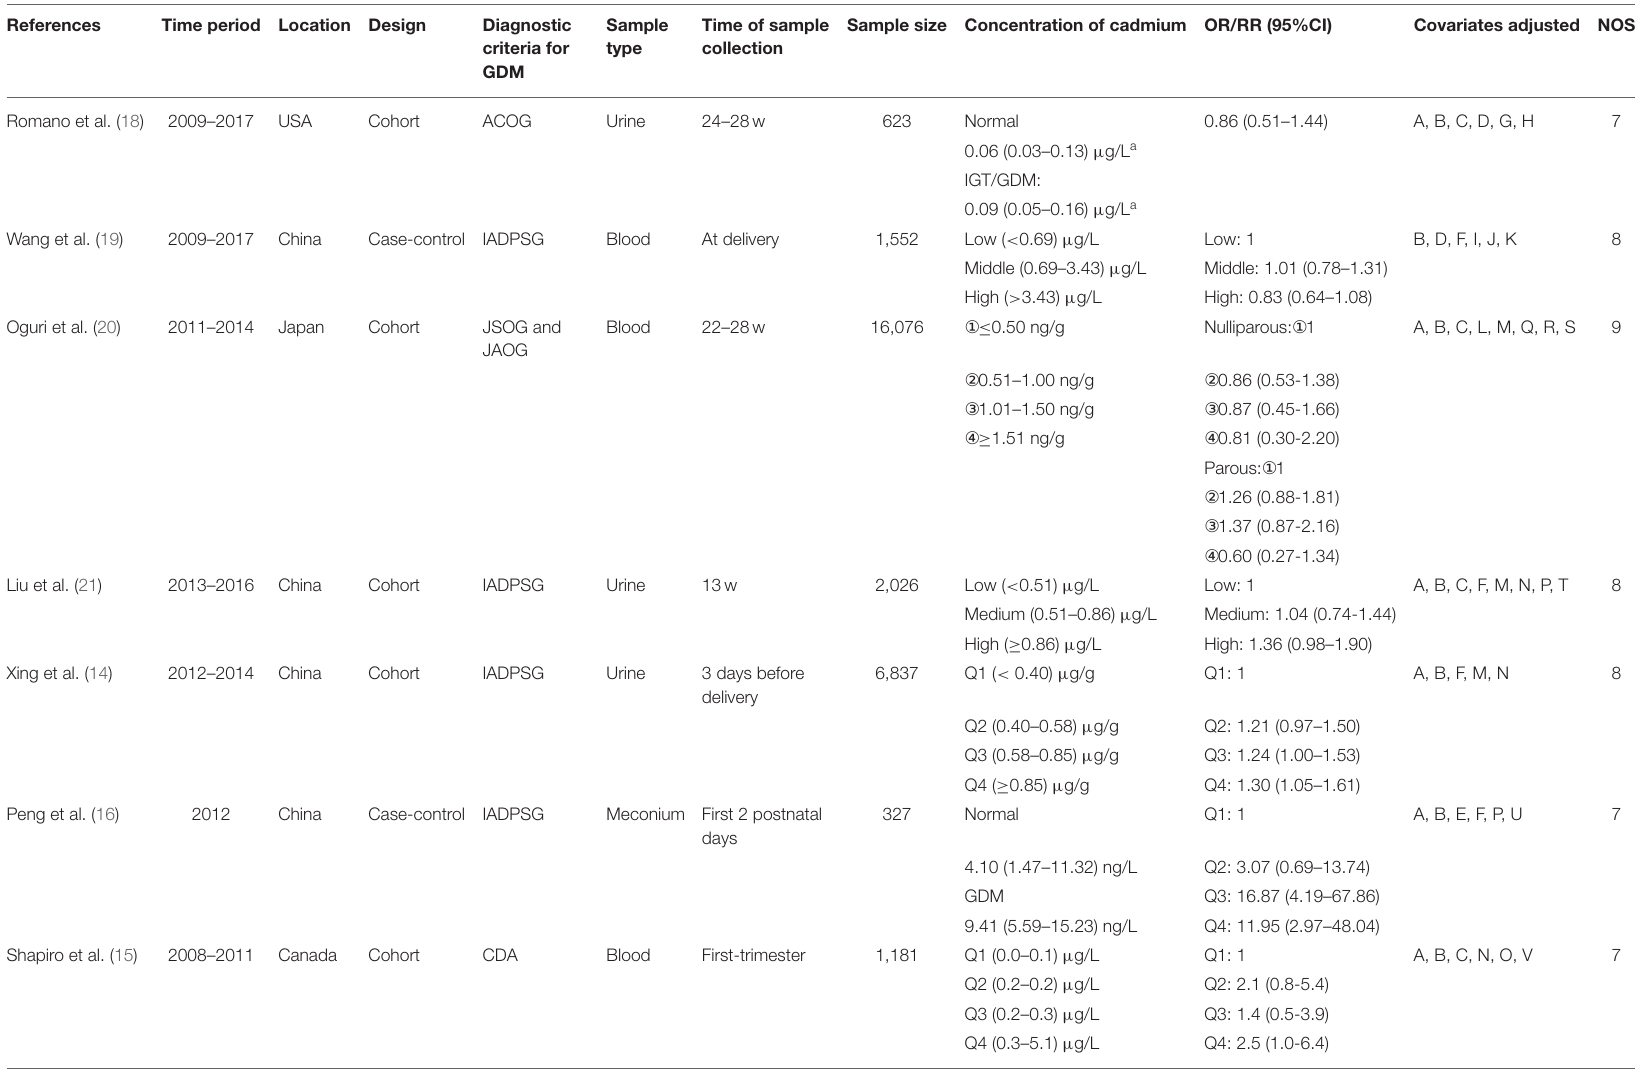
TABLE 1 | Characteristics of eligible studies investigating the association between cadmium exposure and gestational diabetes